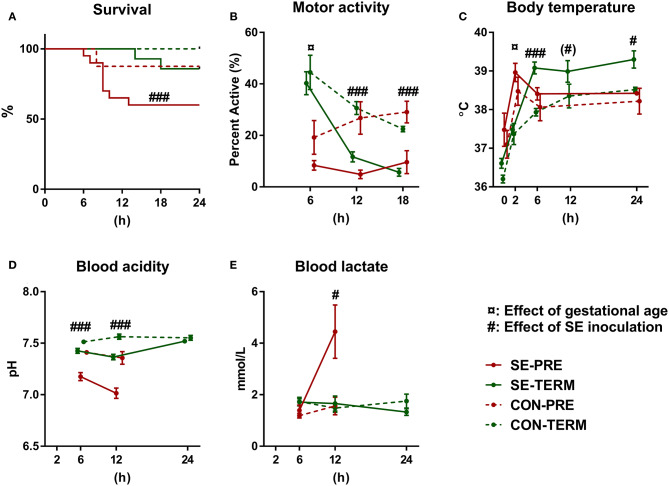
Preterm birth increases susceptibility to Staphylococcus epidermidis bacteremia. Results of Experiment 1 comparing term (TERM) and preterm (PRE) pigs infused with Staphylococcus epidermidis (SE) or saline (CON) immediately after birth, without any enteral feeding. (A) Survival rates 24 h post inoculation. (B) Motor activity, shown as the fraction of time when pigs were physically moving at 2–18 h post inoculation. (C) Body temperature 2–24 h post inoculation. (D) Blood pH 6–24 h post inoculation. (E) Blood lactate levels 6–24 h post inoculation. (A) Presented as Kaplan Meyer curves. (B–E) Presented as means with corresponding standard errors. (#): Effect of SE (p ≤ 0.1 ≥ 0.05), #: Effect of SE (p < 0. 05), ###: Effect of SE (p < 0.001), ¤: Effect of gestational age (p < 0.05).